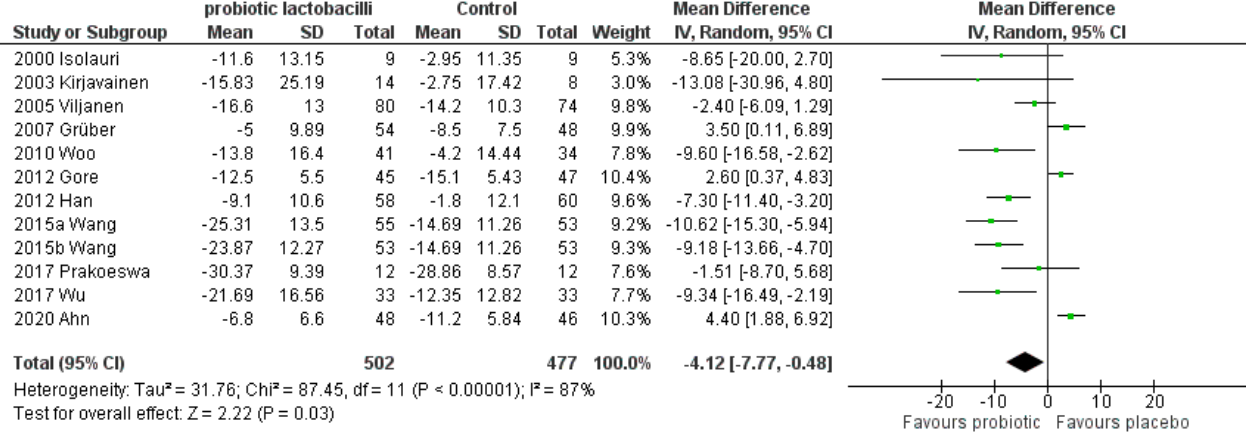
Figure 7. Subgroup meta-analyses of the e ff ect of single-strain probiotic lactobacilli compared to